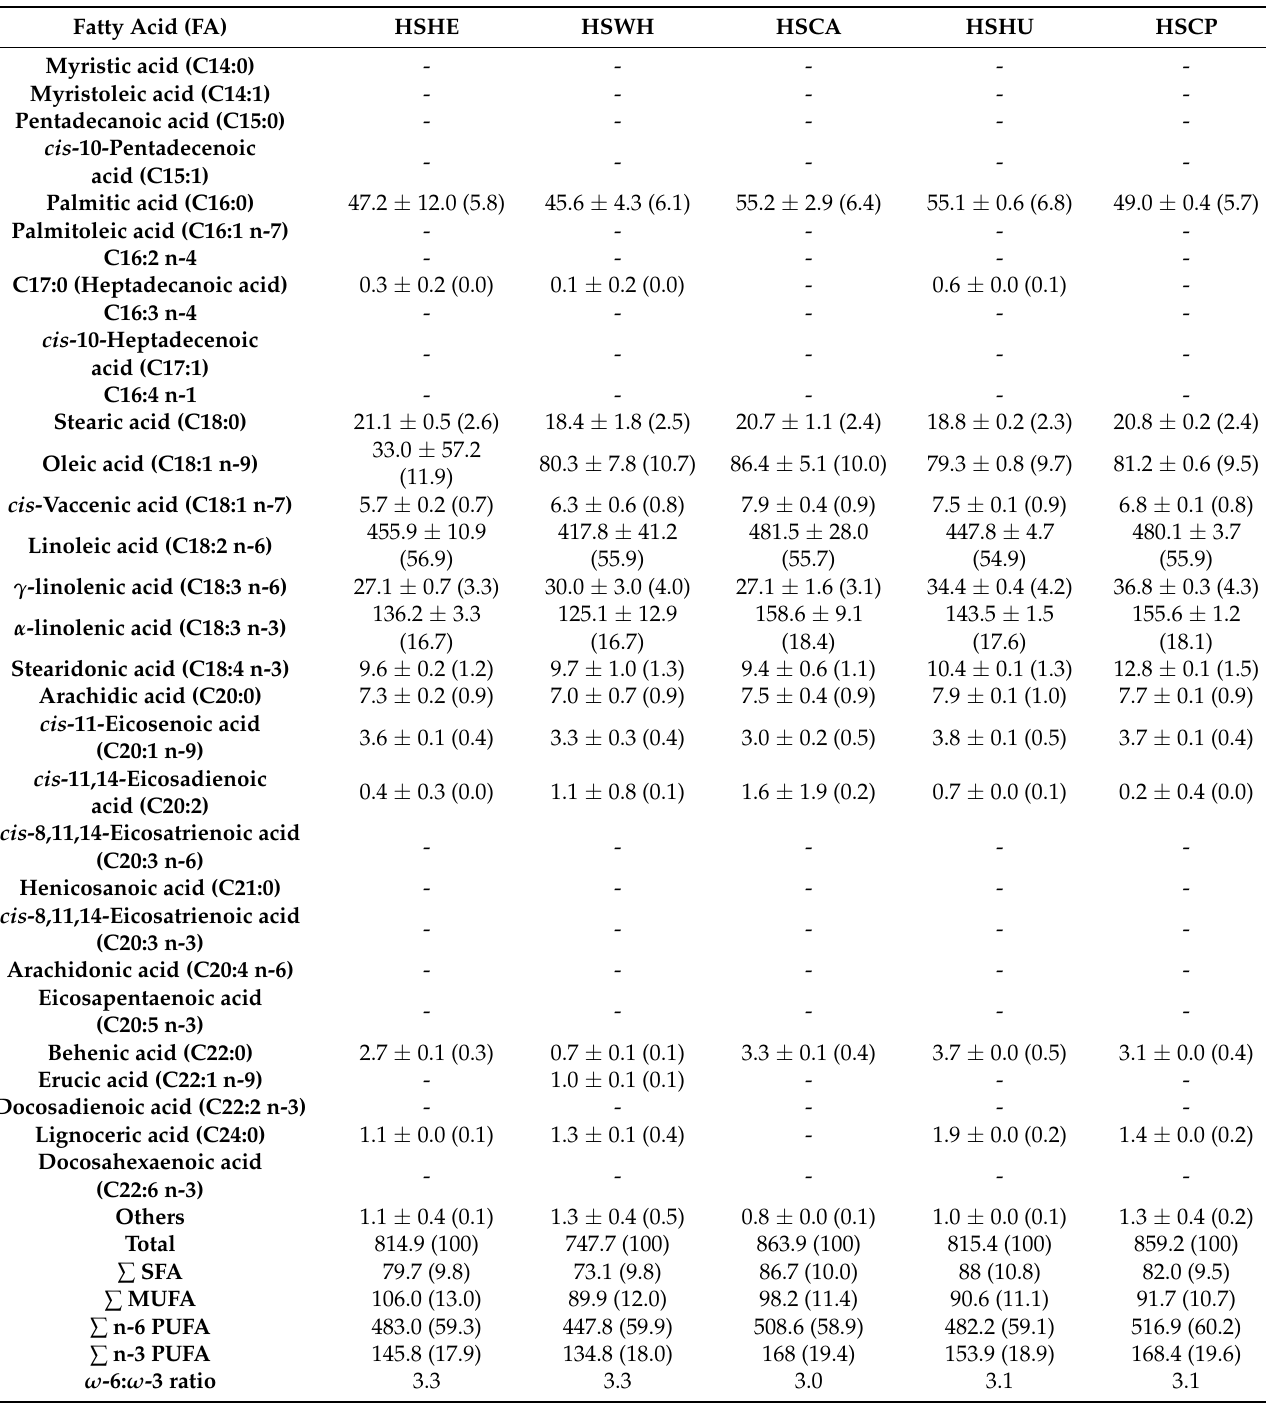
Table 3. Fatty acid profile of oil extracted from hemp hearts (HSHE), hemp whole seeds (HSWH), hemp cake (HSCA), hemp seed hulls (HSHU) and cold-pressed hemp oil (HSCP). Results are expressed in mg/g biomass and the percentage of individual fatty acid in the oil is given in the